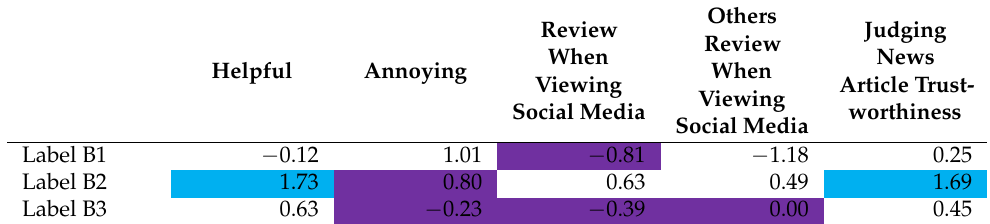
Table A4. Statistical significance calculations for Table 11 data.